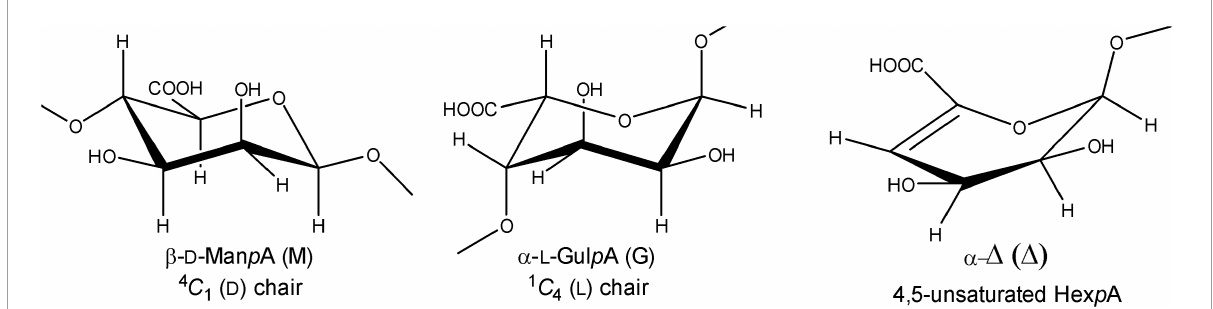
FIGURE1 Structures of β - D -mannopyranosyluronic acid, α - L -gulopyranosyluronic acid, and 4-deoxy- α - L - erythro -hex-4-enopyranosyluronic acid units, as present in (enzymatically degraded)